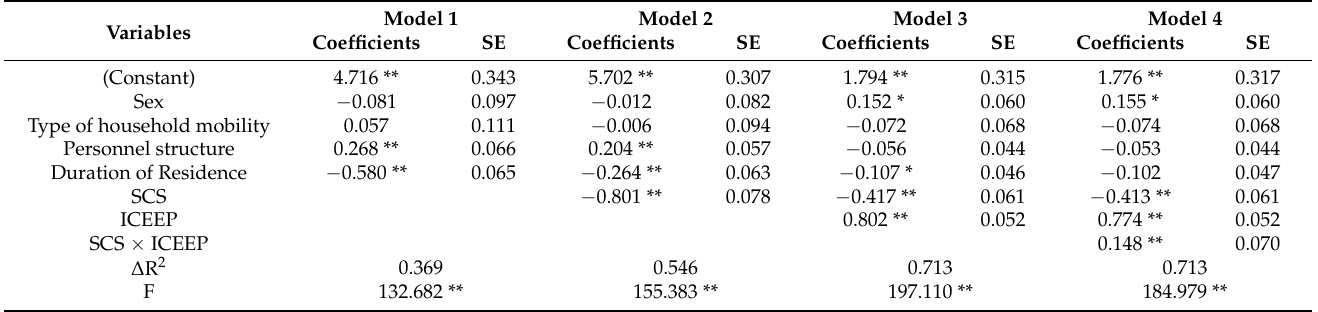
Table 6. Moderating effect of ICEEP on the relationship between SCS and